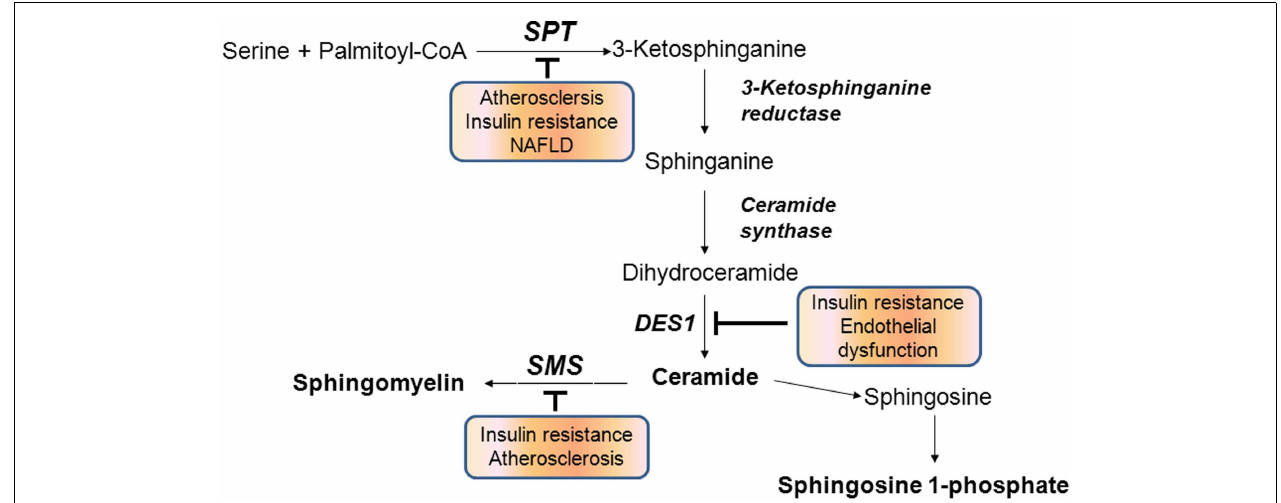
FIGURE 2 | Sphingolipid biosynthetic pathways. Inhibition of indicated biosynthetic enzymes is associated with prevention of chronic metabolic diseases. SPT, serine palmitoyltransferase; DES1, dihydroceramide desaturase 1; SMS, sphingomyelin synthase.